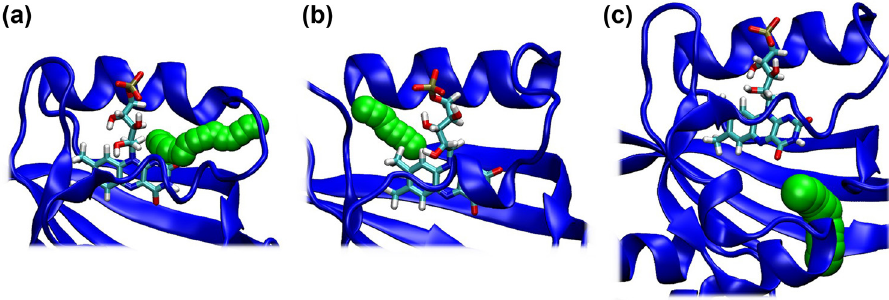
Figure 4: More persistent tunnels leading to the three binding cavities and connecting outside to the FMN cofactor in the C71S